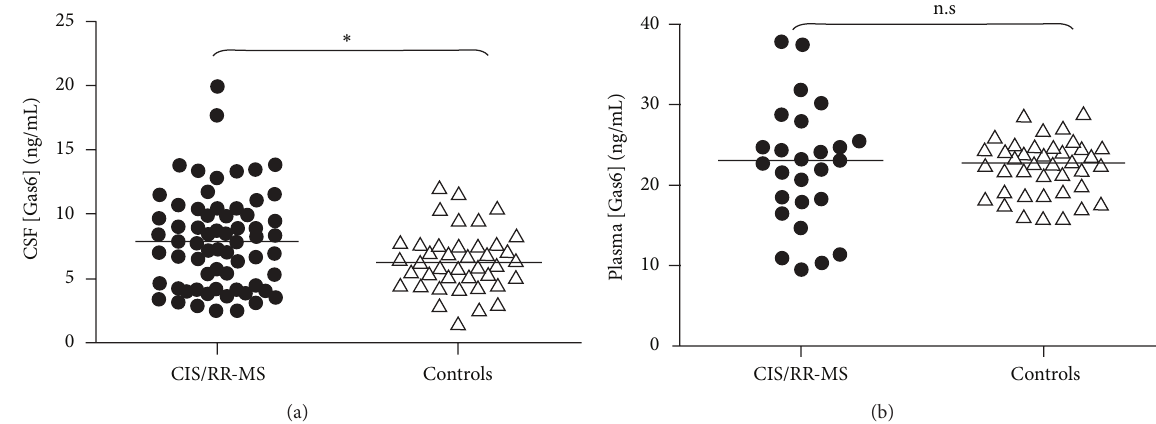
Figure 1: Gas6 concentration in CSF of patients with MS. (a) The scatter plot displays CSF Gas6 concentrations of patients with MS (black circles) with respect to controls (white triangles). ∗ indicates 𝑃 < 0.05 in statistical comparison of the means (Student’s t test); the horizontal bar indicated the mean value. (b) The scatter plot displays plasma Gas6 concentrations of patients with MS (black circles) with respect to controls (white triangles). The horizontal bar indicated the mean